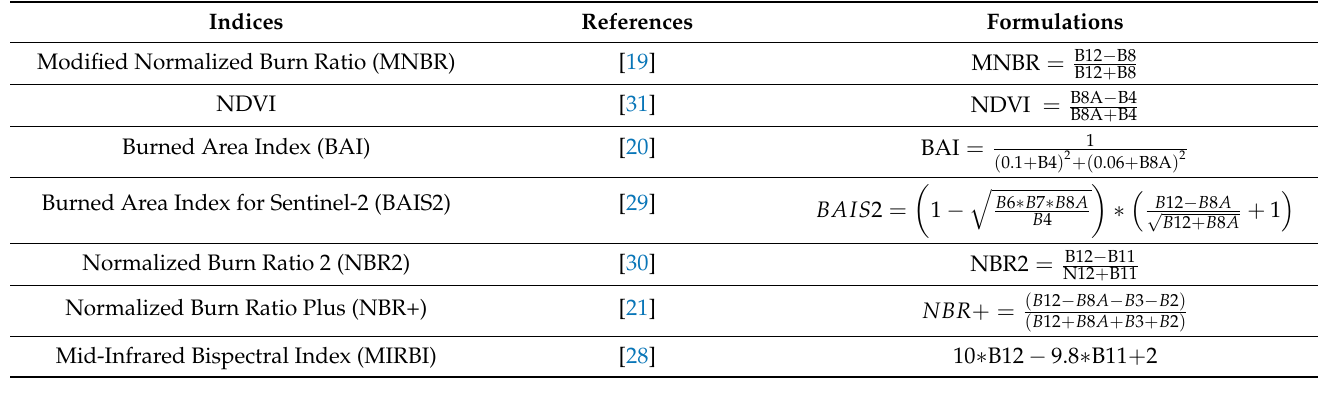
Table 3. List of some widely used burned area indices.